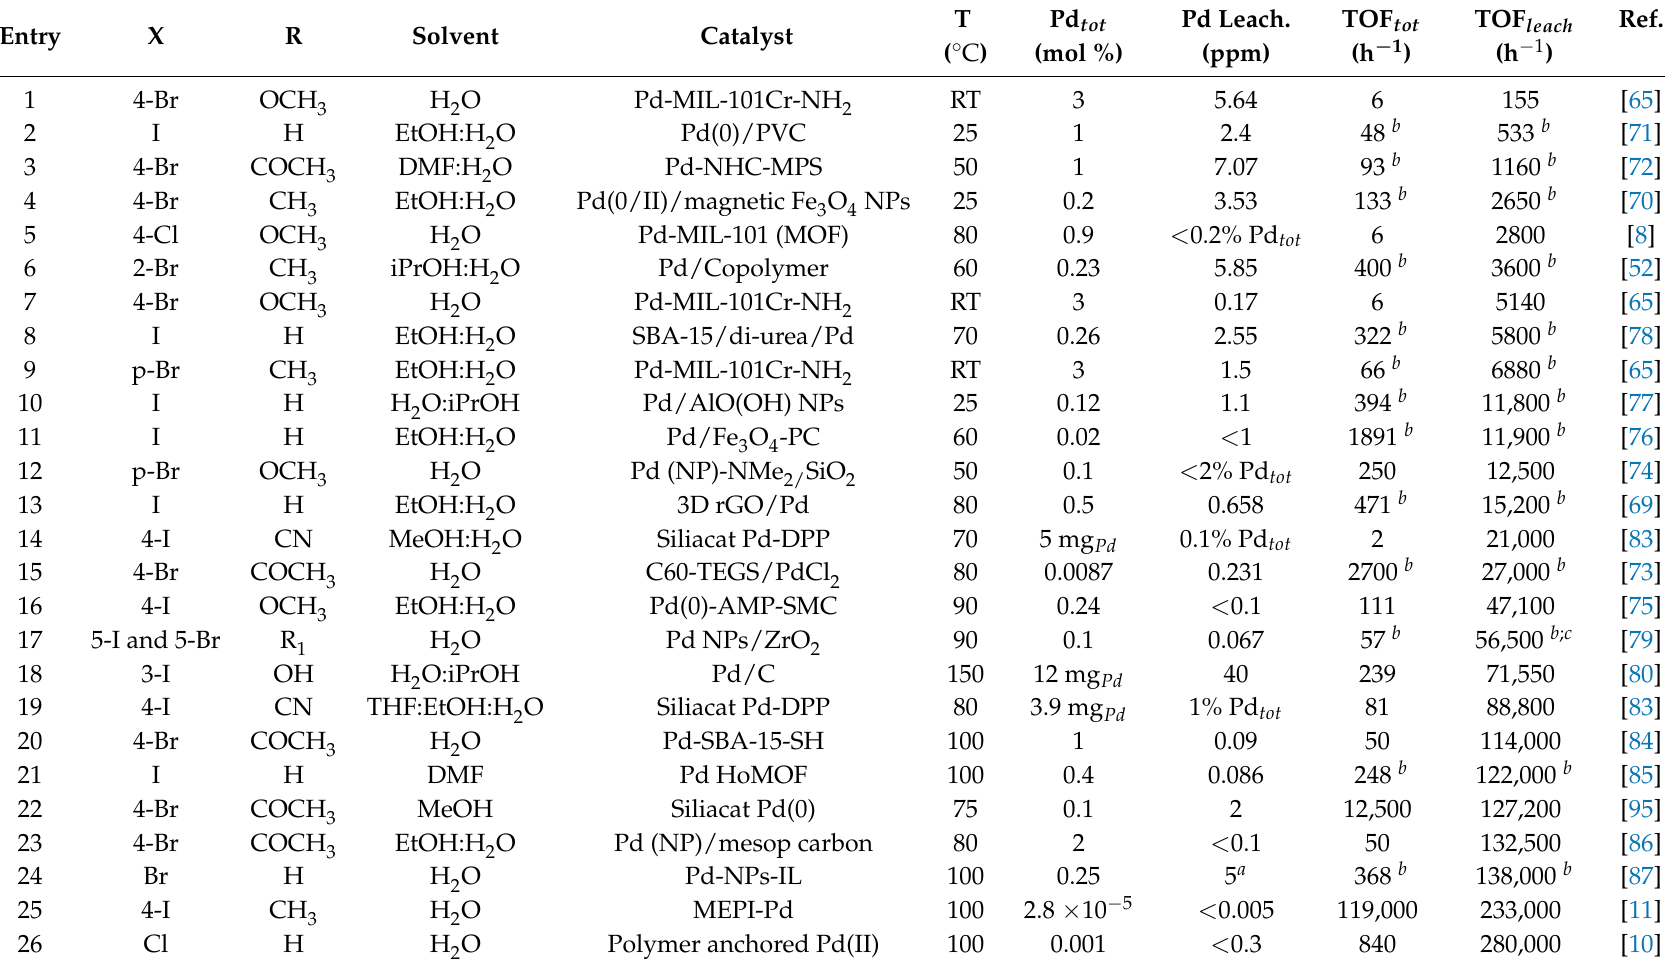
Table 3. Literature data stating for putative heterogeneous catalysis. a in isolated product; b average value for several runs; R’ = H (see Figure 3) except c : see text; R 1 = CH , H or COCH ; NA: not 3 3